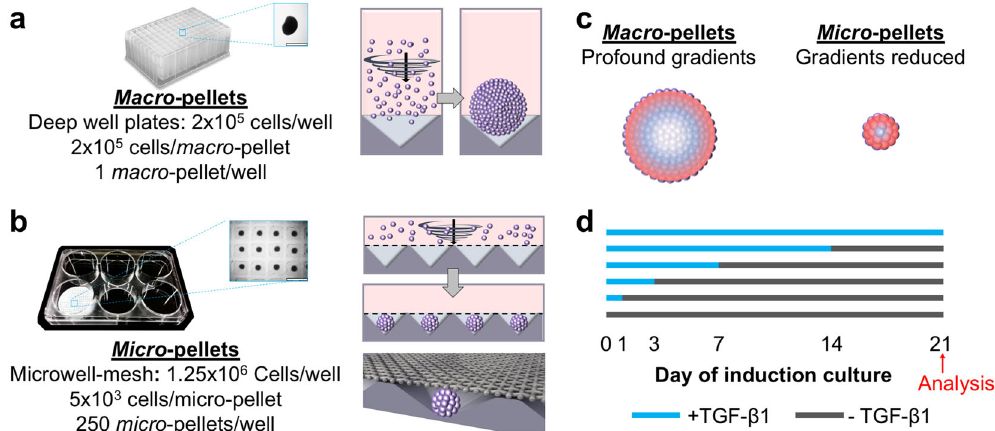
Fig. 1 Schematic of experimental procedures. a , b Different cell seeding densities were used to generate macro -pellets or micro -pellets of speci fi c size in deep-well plates or Microwell-mesh plates, respectively. Micro -pellets were retained in discrete microwells by the nylon mesh bonded over the microwell openings (see Supplementary Movie 1). Retention by the mesh enabled long-term micro -pellet culture, including multiple medium exchanges. c Diffusion gradients are reduced in smaller diameter micro -pellets relative to larger diameter macro -pellets 16,17 . d Cultures were carried out for 21 days total, with blue lines representing culture days with TGF- β 1 in the medium, and gray lines representing culture days without TGF- β 1 in the